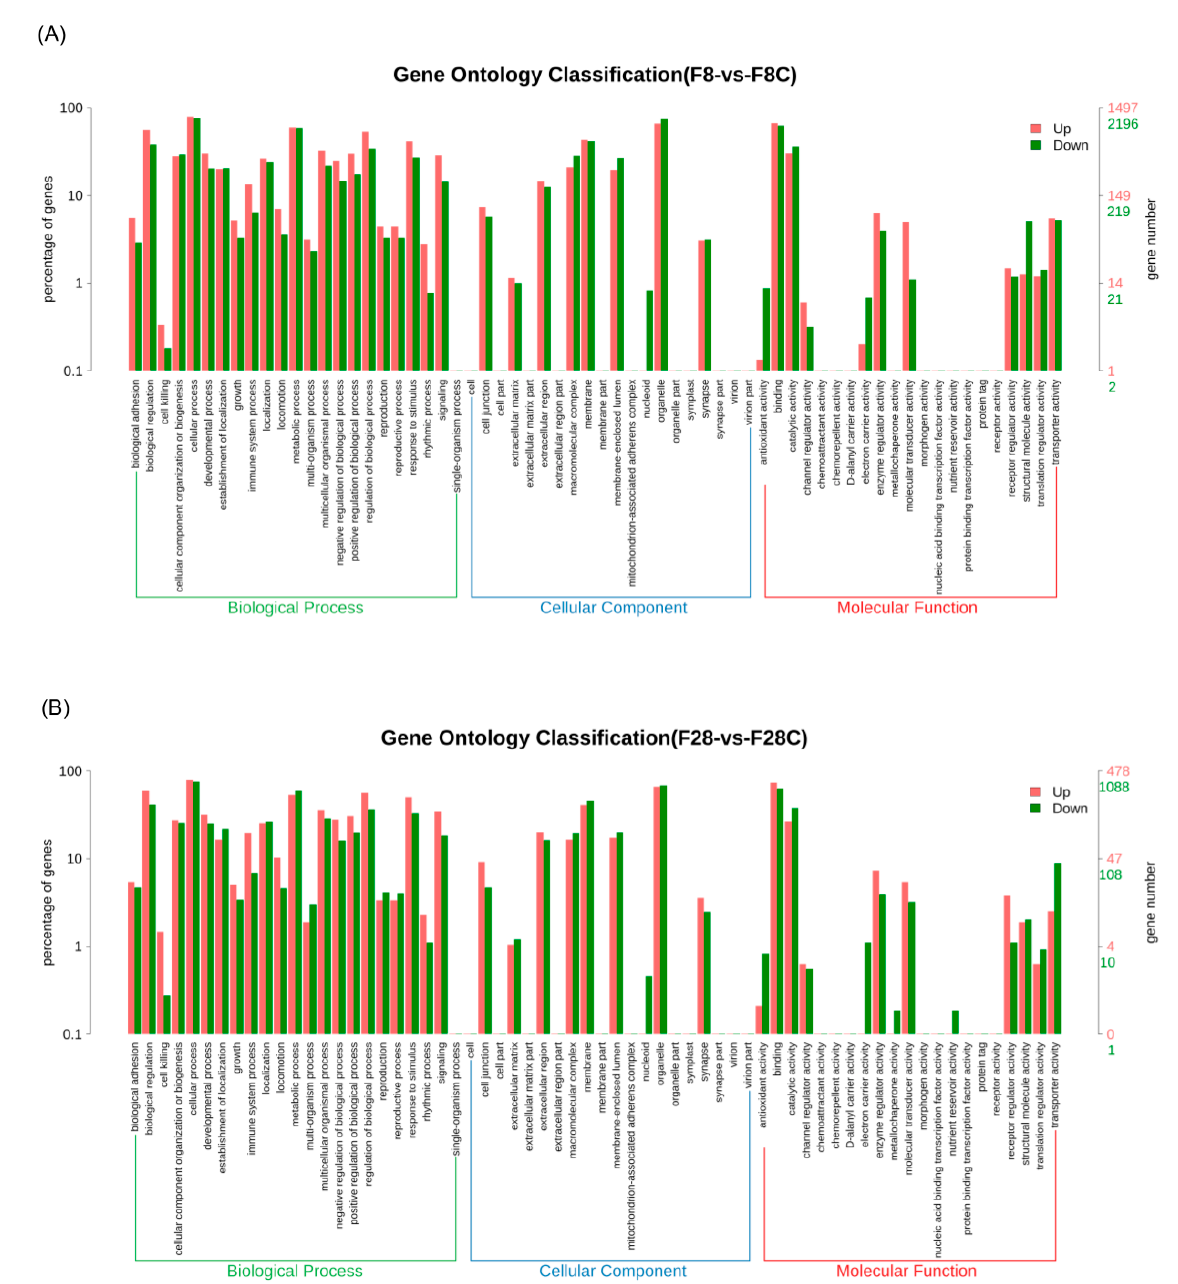
Figure 4. Gene ontology classification of significantly upregulated and downregulated genes in the liver transcriptome of yellowcheek starved for ( A ) 8 and ( B ) 28 d compared with the control groups at the same time.